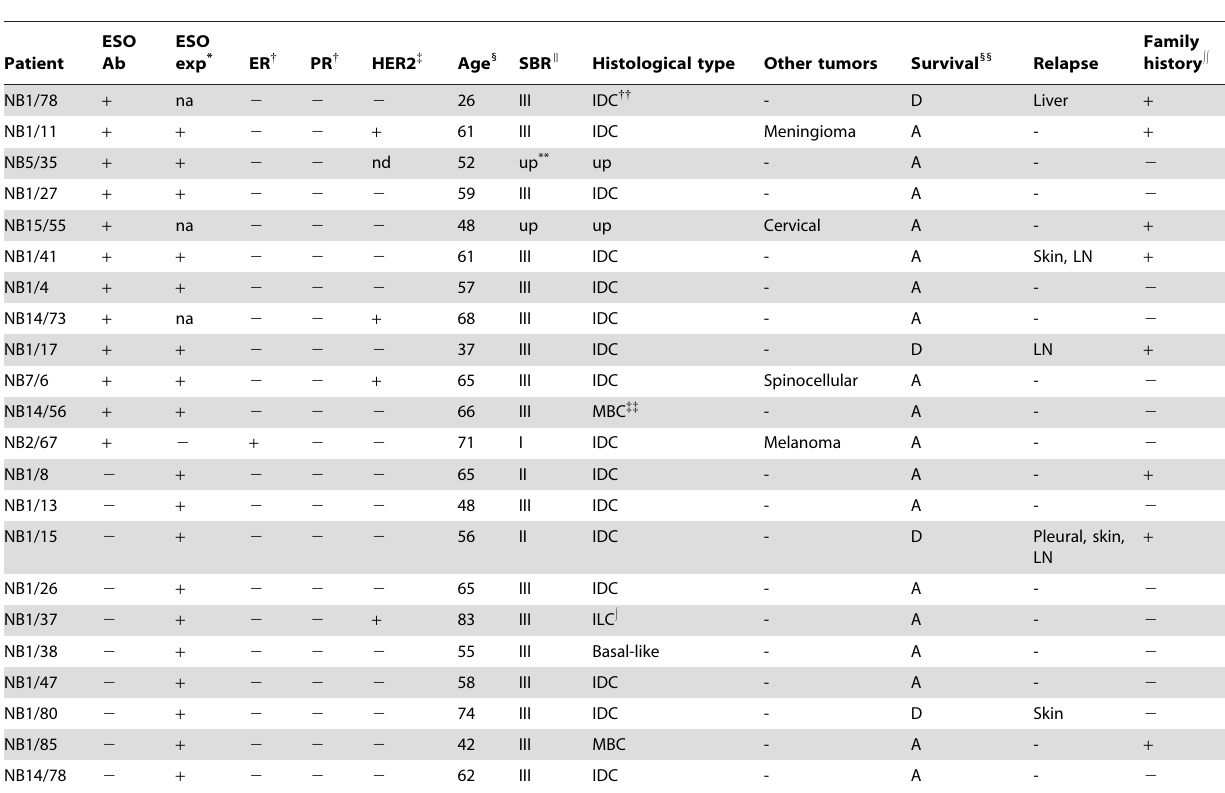
Table 1. BC patients with detectable ESO Ab and/or ESO expression and characteristics of the corresponding tumors.